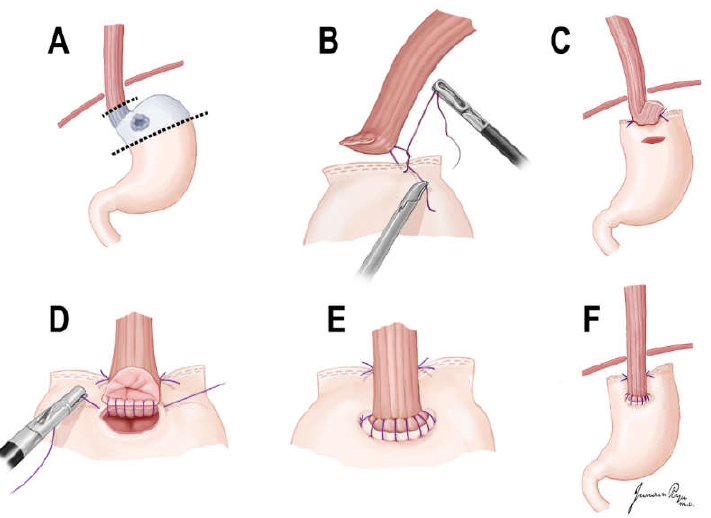
Figure 1. Illustration of SPADE operation. ( A ) Laparoscopic D1+ proximal gastrectomy was performed. ( B , C ) Both distal part of posterior wall of esophagus and proximal part of anterior wall of stomach were fixed with two interrupted sutures. ( D ) After an opening was made, one barbed continuous suture (V-Loc™) initiated at the left corner of esophagus posterior wall and stomach anterior wall, ended on the opposite right side. ( E ) After suturing of posterior wall anastomosis, anterior wall anastomosis was performed in the same maneuver. ( F ) After anastomosis was completed, a spade shape is made.